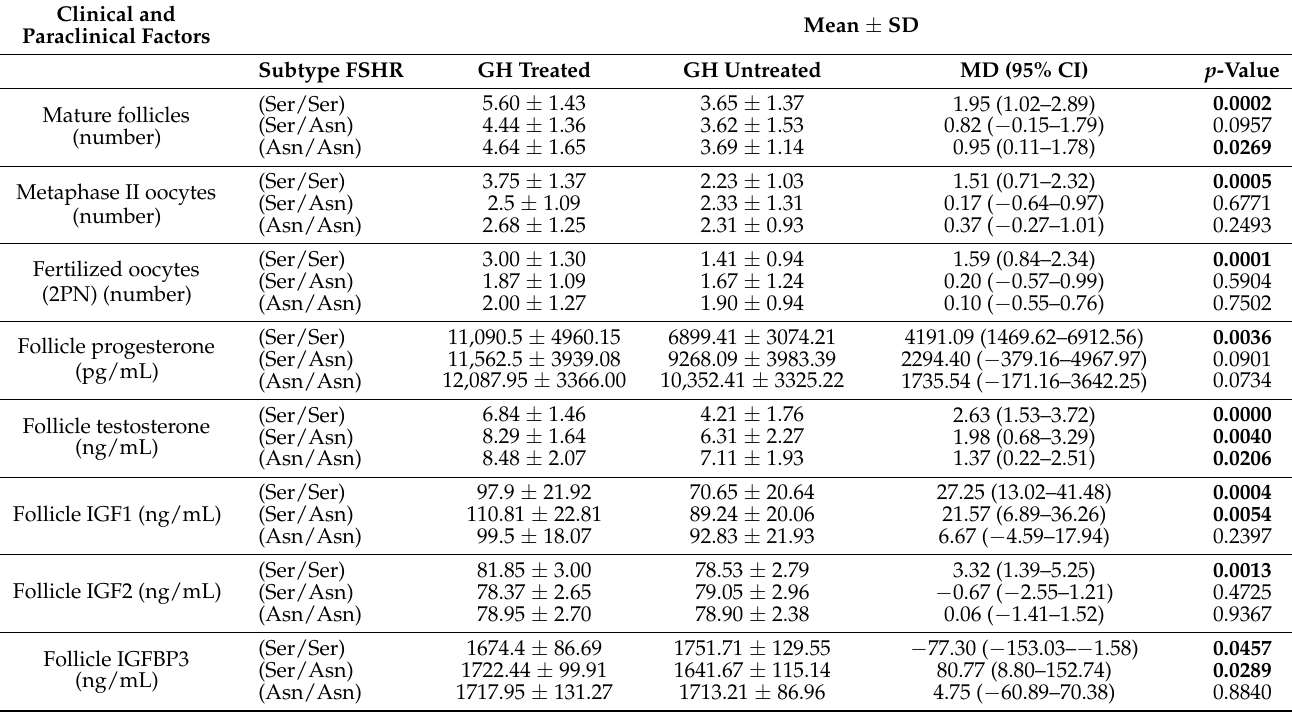
Table 2. Comparative analysis of clinical and paraclinical factors among study participants with three FSHR subtype polymorphisms who received GH treatment ((Ser/Ser) n = 20; (Ser/Asn) n = 16; (Asn/Asn) n = 22) and those who did not receive GH treatment ((Ser/Ser) n = 17, (Ser/Asn) n = 21; (Asn/Asn) n =